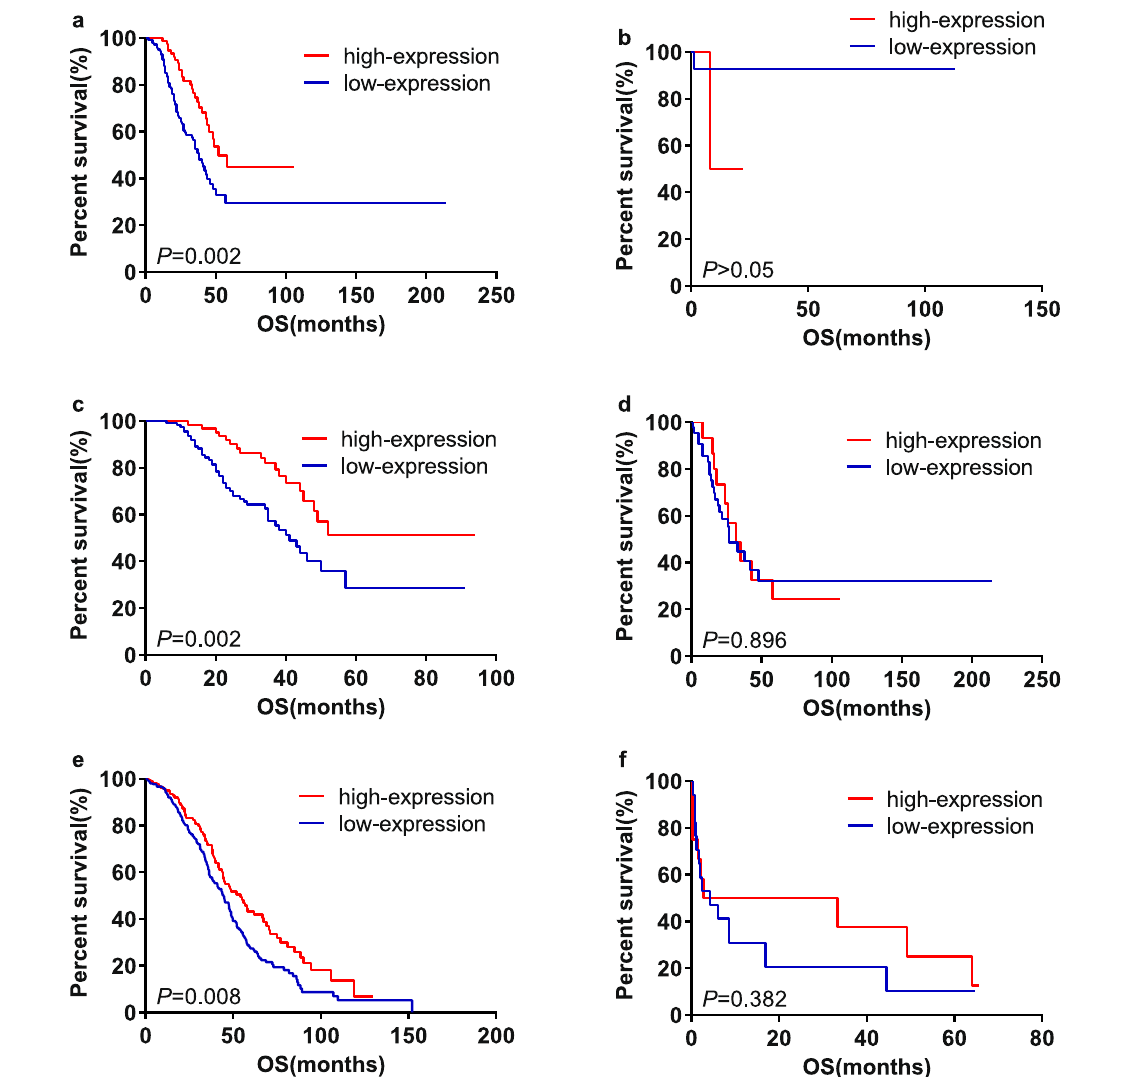
Figure 5. Stratification analysis of IL-6R mRNA on survival. ( a ) Kaplan-Meier analysis of patients with platinum treatment in dataset GSE9891. ( b ) Kaplan-Meier analysis of patients with no platinum treatment in dataset GSE9891. ( c ) Kaplan-Meier analysis of patients with taxane treatment in dataset GSE9891. ( d ) Kaplan-Meier analysis of patients with no taxane treatment in dataset GSE9891. ( e ) Kaplan-Meier analysis of patients with additional radiation therapy dataset in TCGA. ( f ) Kaplan-Meier analysis of patients with no additional radiation therapy dataset in TCGA.